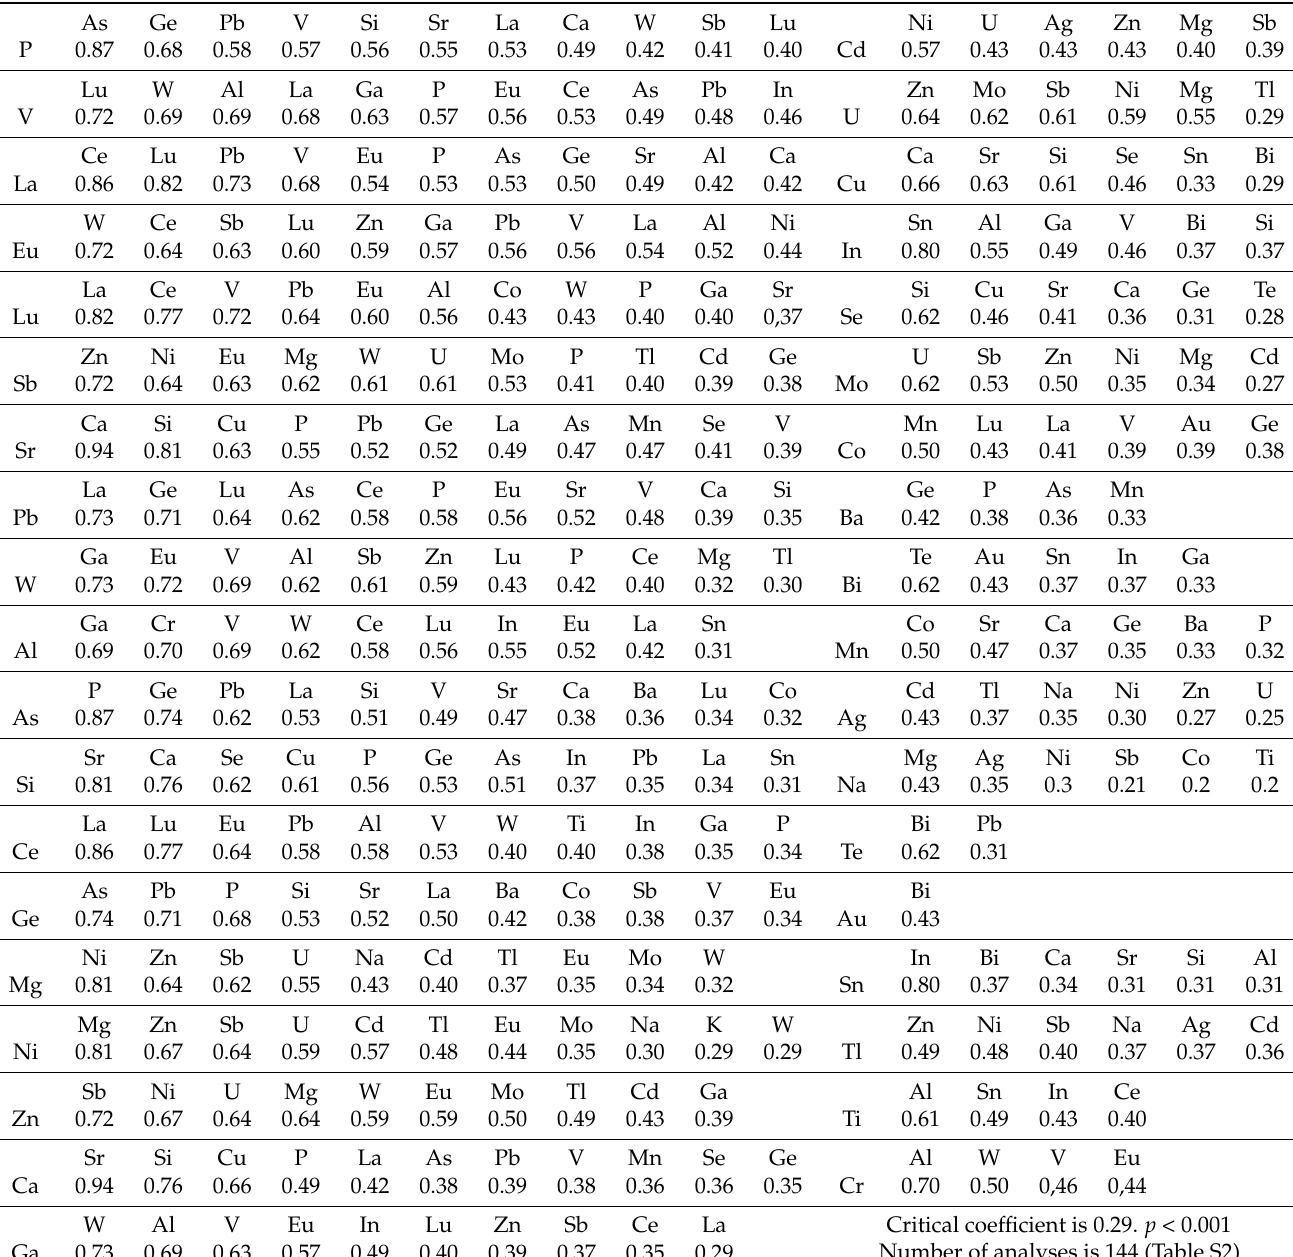
Table 4. The correlation coefficients of TEs calculated for all IOH types of the Pobeda-1 hydrothermal